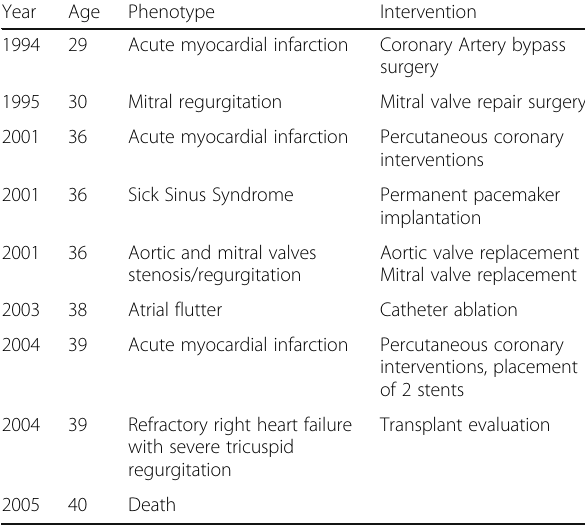
Table 1 Time course of the phenotype in the